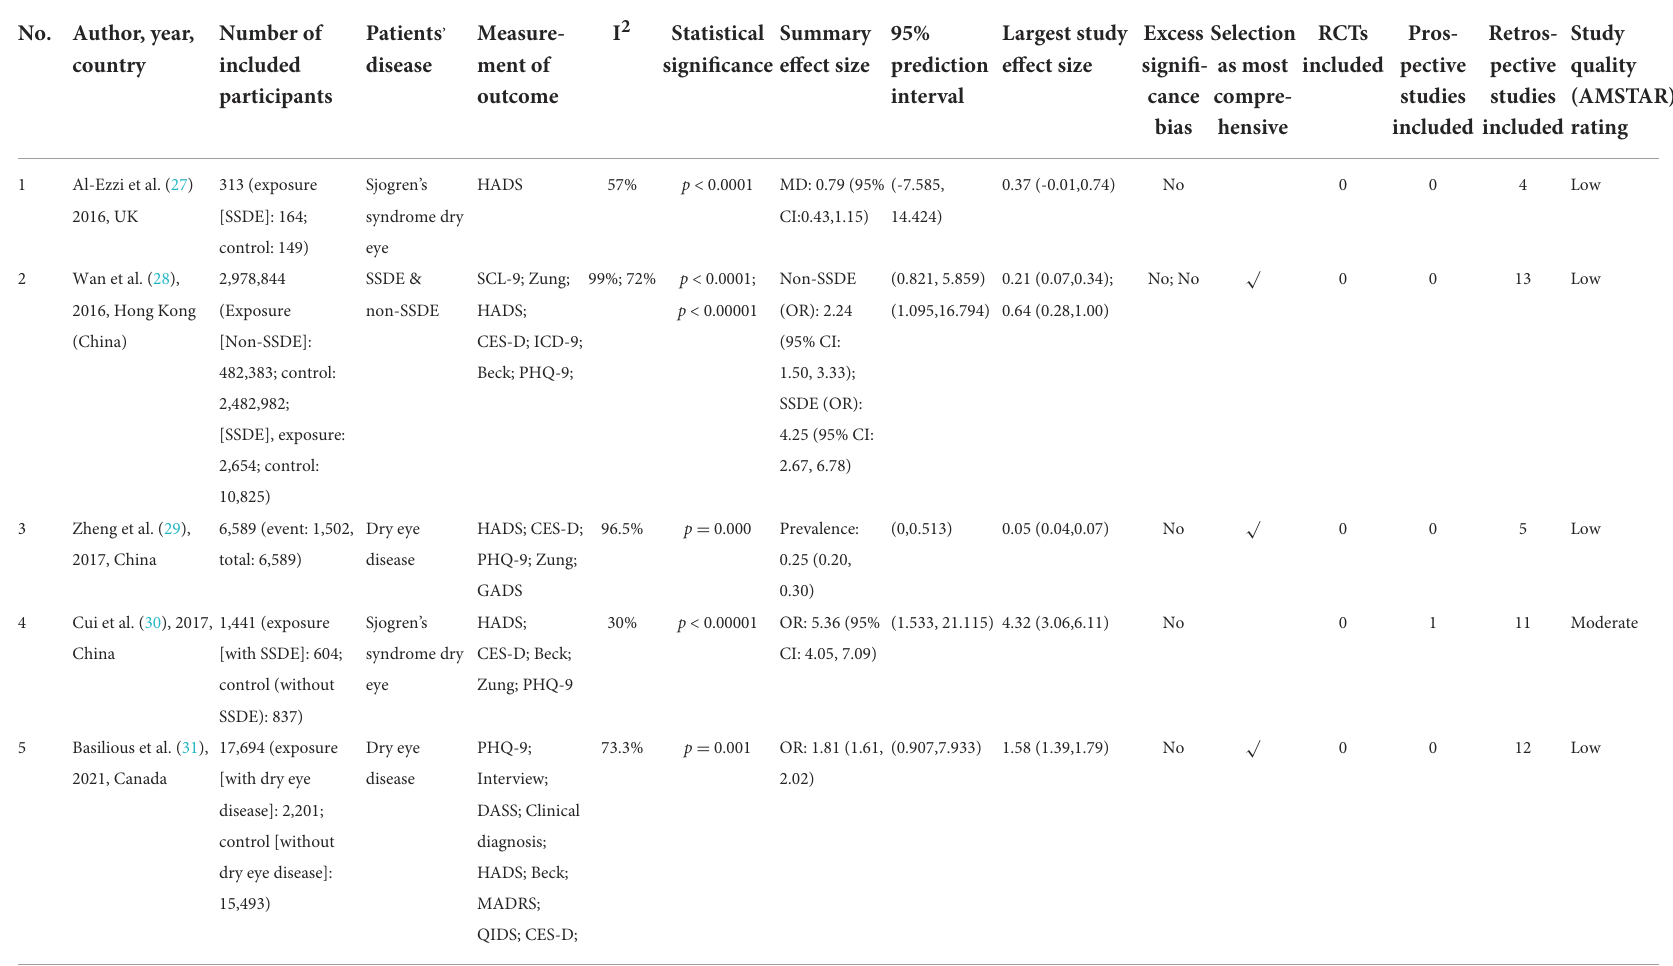
TABLE 1 Characteristics of the included